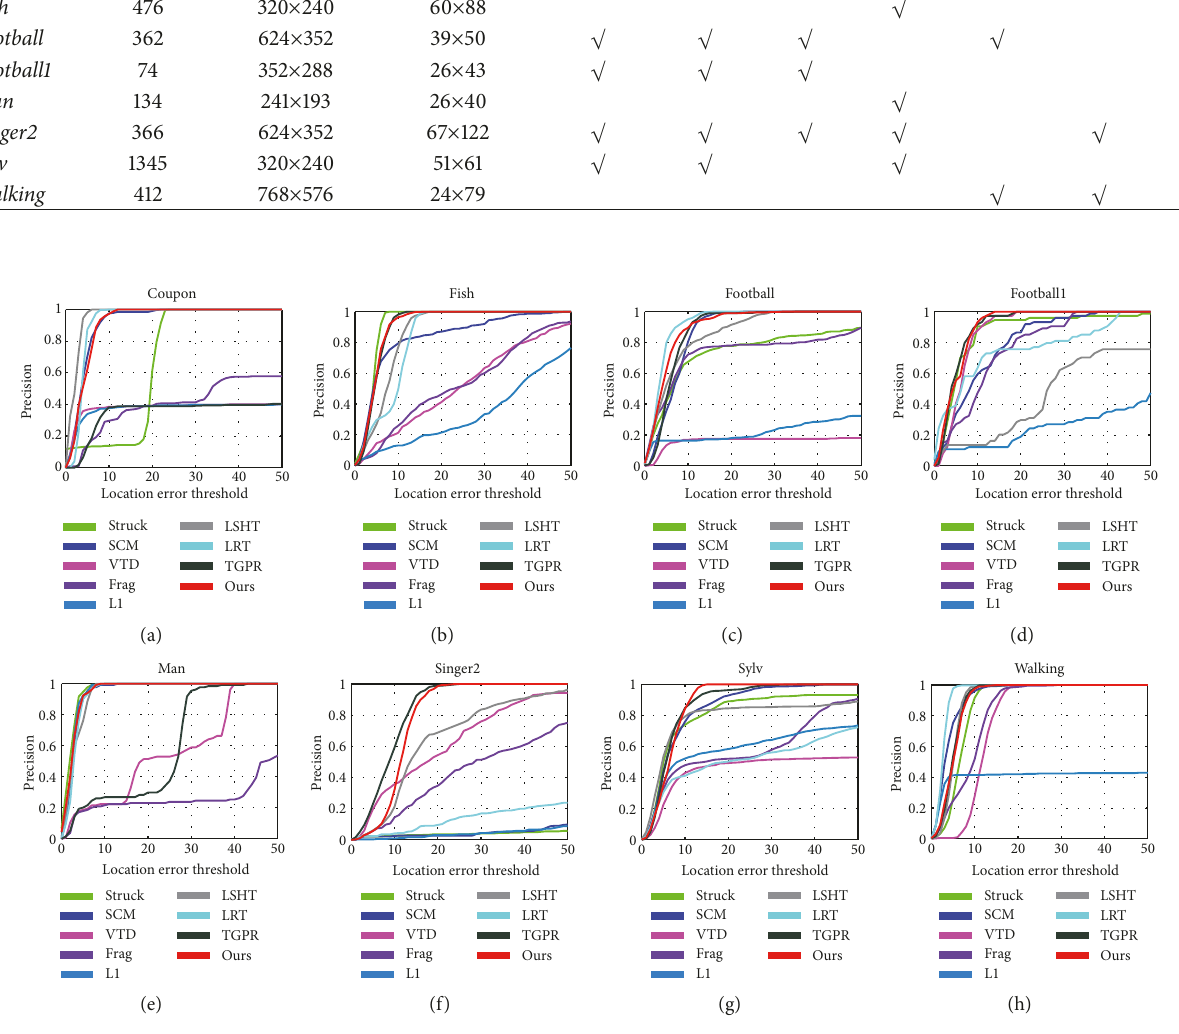
algorithm achieves the best or the second best tracking results in most video sequences. Struck, LSHT, LRT, and TGPR also achieve robust tracking results in some video